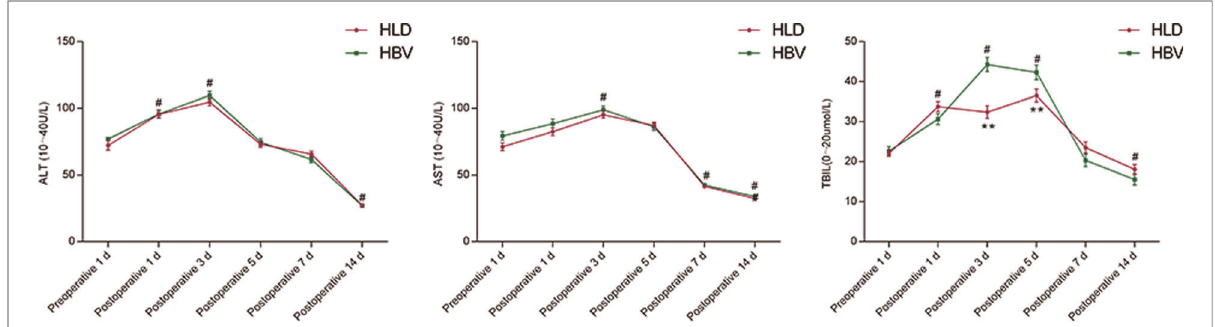
TABLE 2 Comparison of complications after splenectomy in the two groups.